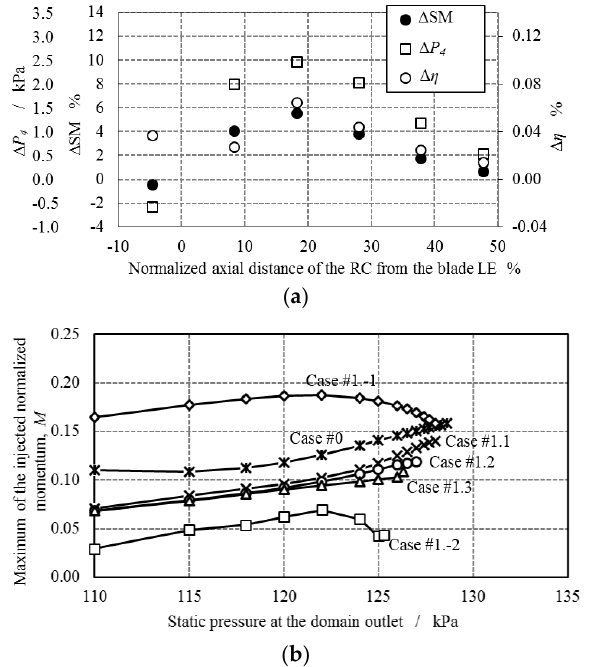
Figure 7. Changes in the compressor performance and in the intensity of the injected momentum over the compressor operating range. ( a ) Comparison of the axial compressor rotor overall characteristics: stall margin (ΔSM), outlet static pressure change at the near-stall (NS) condition (Δ P 4 ), and rotor adiabatic half-stage efficiency at peak efficiency (PE) condition (Δ η ). ( b ) Variation in the injected flow momentum M with outflow pressure and RC axial position.